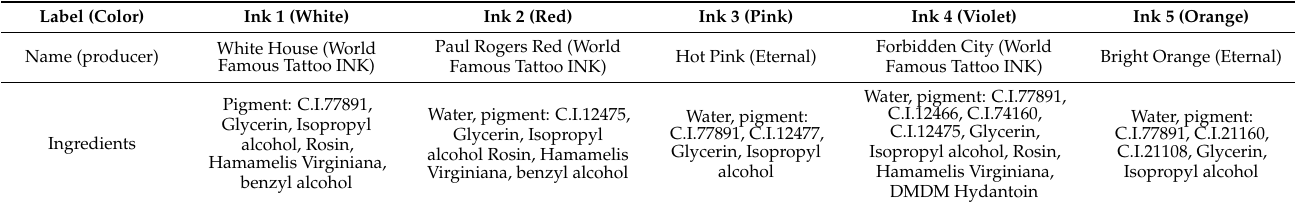
Table 2. Compositions and descriptions of inks used in the experiment.